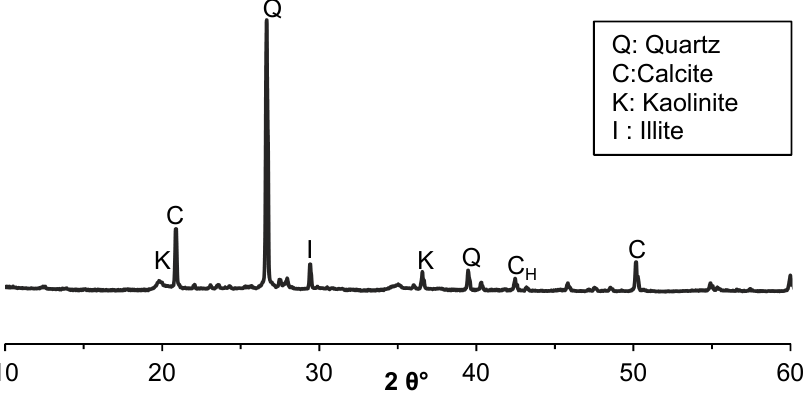
Figure 2. XRD mineralogical analysis of sediment.